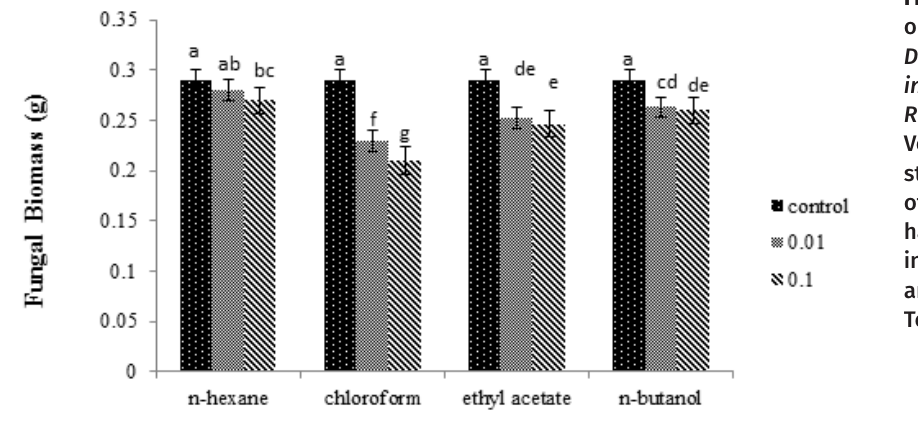
Figure 2. Influence of organic fractions of Datura metel leaf with in vitro growth of fungus Rhizoctonia solani Vertical bars indicated standard error of means of replicates. Values having letters showed insignificant variations analyzed through LSD